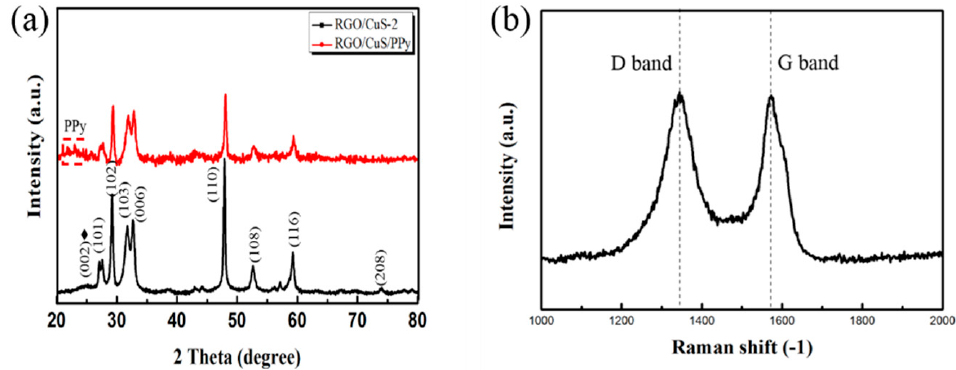
Figure 1. XRD spectra ( a ) and Raman spectra ( b ) of rGO/CuS/PPy sample.